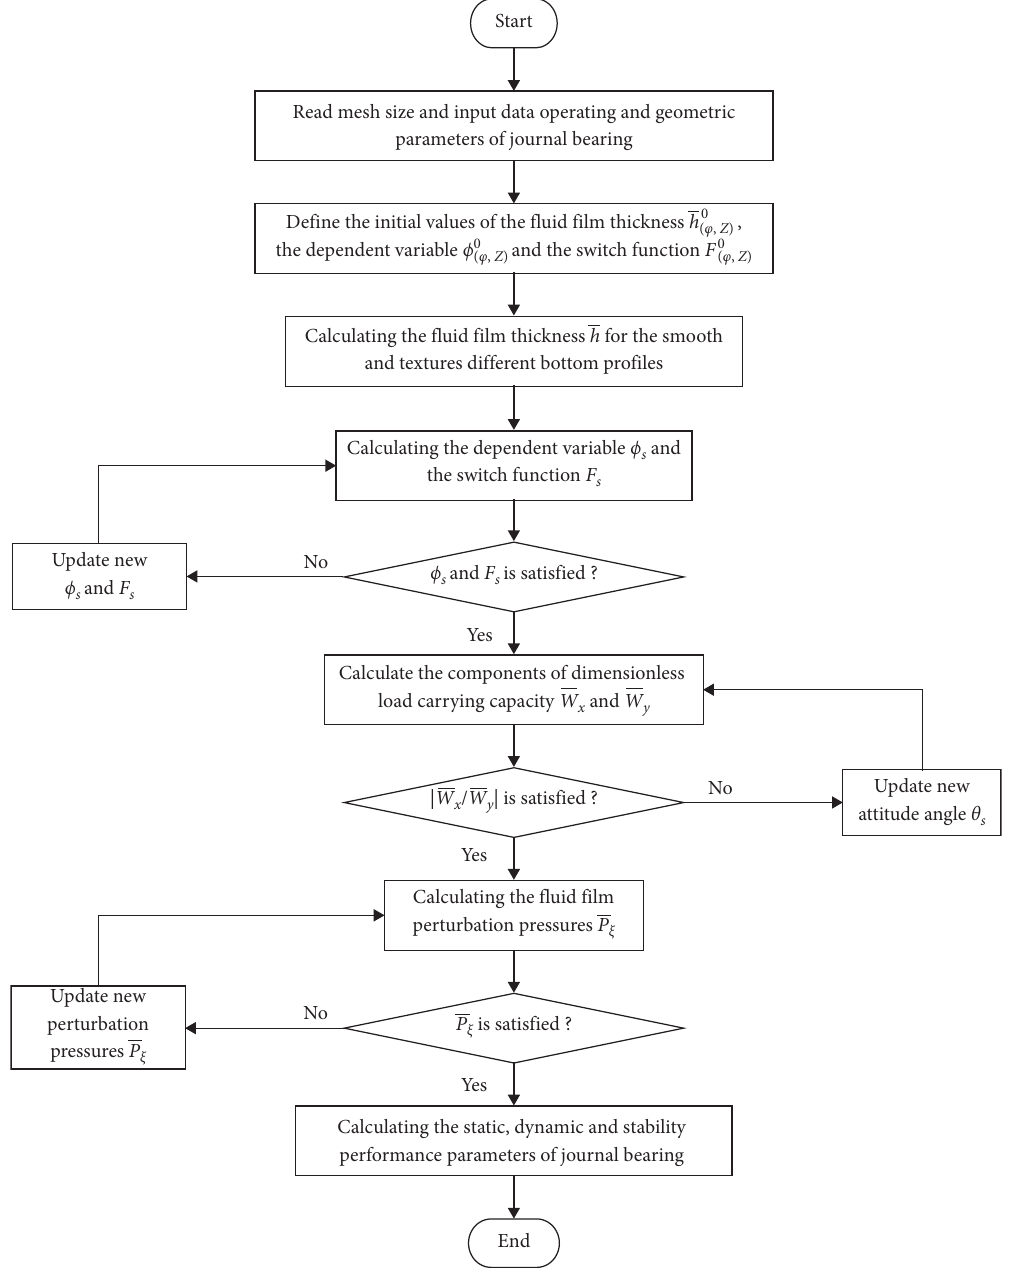
Figure 2: Flowchart of the numerical calculation process for the steady state and dynamic performance parameters of journal